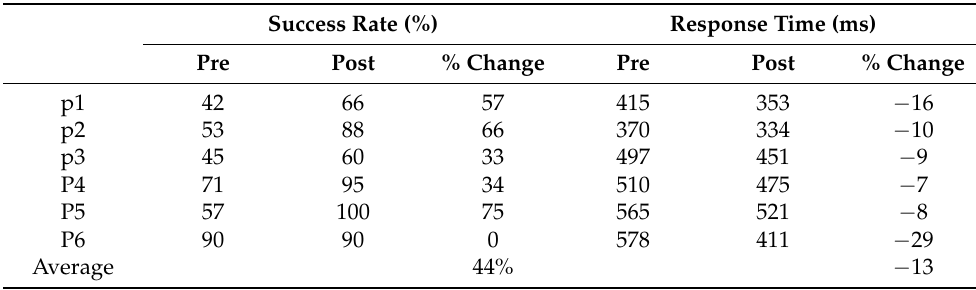
Table 4. Pre- and post-exercise test scores and percentage of change in cone manipulation task for each child. Values are the average of pronation and supination game movements.